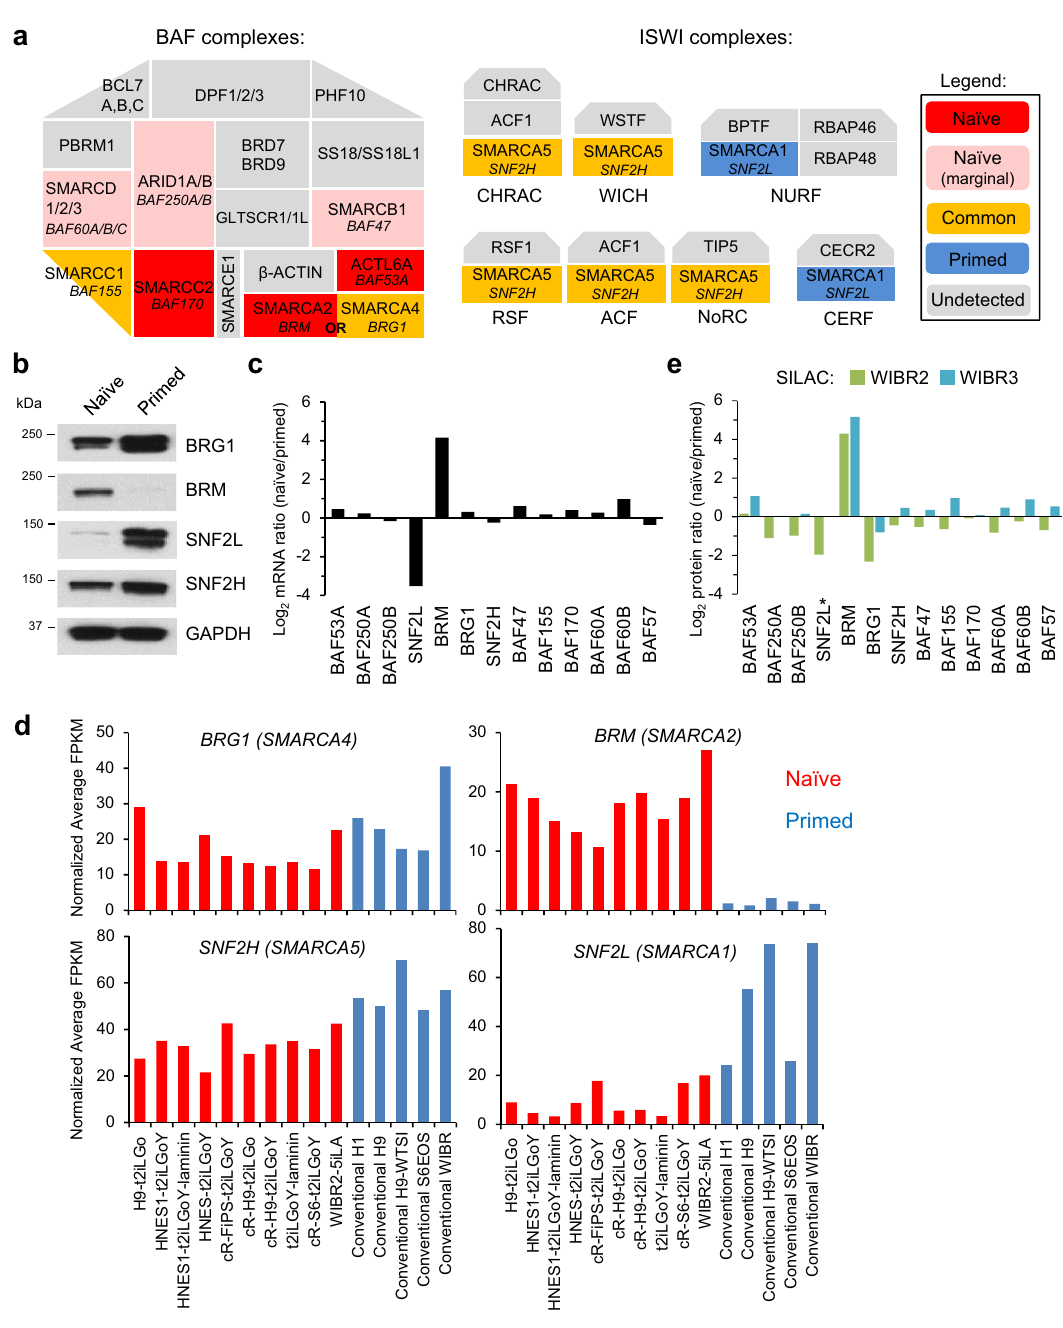
Fig. 2 Differential expression of OCT4-associated SNF2-family ATPases in naïve and primed hESCs. a Illustration of naïve-speci fi c (red/pink), primed- speci fi c (blue), and common (yellow) components of the mammalian SWI/SNF family of subunits (represented as one complex rather than three subcomplexes cBAF, PBAF, and ncBAF) and ISWI complexes identi fi ed in the naïve and primed OCT4 interactomes. Pink color indicates proteins that are identi fi ed with marginal signi fi cance (0.1 < FDR < 0.2) in the naïve OCT4 interactome. b Western blot analysis of ATPase expression in naïve and primed hESCs. Experiment is repeated independently twice with similar results. c log 2 ratios of mRNA expression of BAF and ISWI components in naïve and primed hESCs based on a microarray analysis 4 . d Expression of BRG1 (SMARCA4), BRM (SMARCA2) , and SNF2L (SMARCA1) mRNA transcripts in the alternative t2iLGoY culture condition for naïve human pluripotency (red) and parental primed hESCs (blue) according to RNA-seq data 5,46 . e log 2 ratios of protein expression of BAF and ISWI components in naïve and primed hESCs based on SILAC followed by MS analysis in two naïve and primed hESC lines. *SNF2L was quanti fi ed by MS only in WIBR2